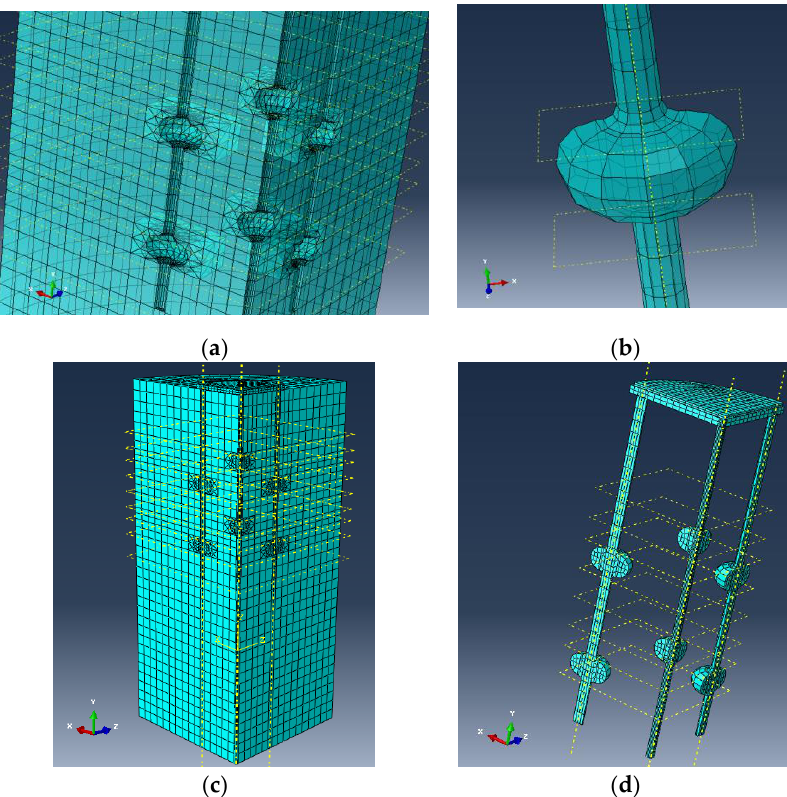
Figure 13. Grid division and location sketch map of the model: ( a ) perspective drawing of local grid division of local soil around pile; ( b ) perspective drawing of grid division of expanding part; ( c ) 1/4 model parts location diagram; and ( d ) schematic diagram of pile, cushion, and loading plate.